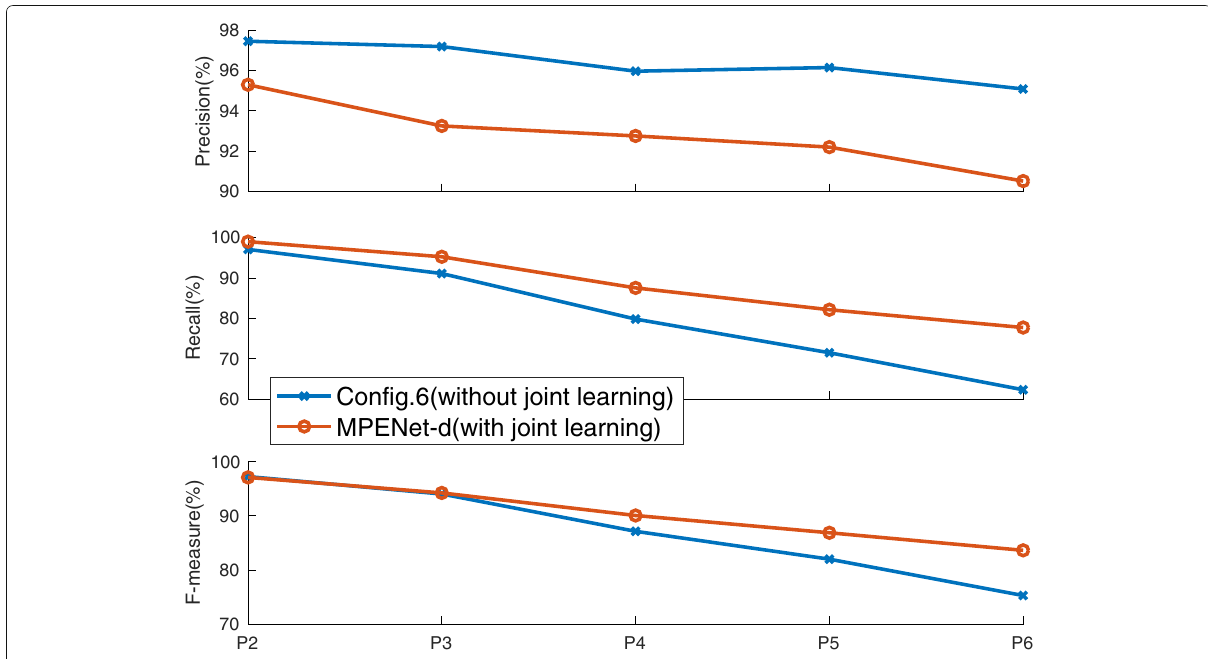
Fig. 10 Joint learning comparison results. Precision, Recall, and F-measure are shown in three subplots from top to bottom, respectively, where y axis indicates percentage value and x axis indicates polyphony level. Three subplots share same legends